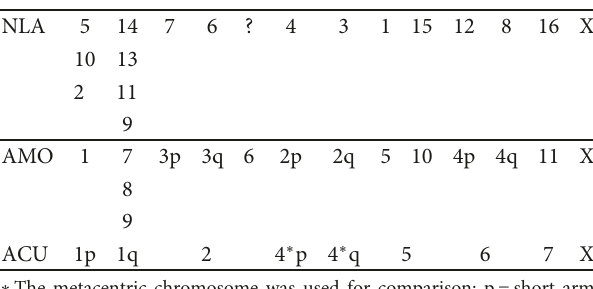
Table 2: Correspondence of GTG-banded chromosomes of Akodon cursor (ACU; 2n =14, FN =19), A. montensis (AMO; 2n =24, FN =42), and Necromys lasiurus (NLA; 2n=34, FN=34). NLA